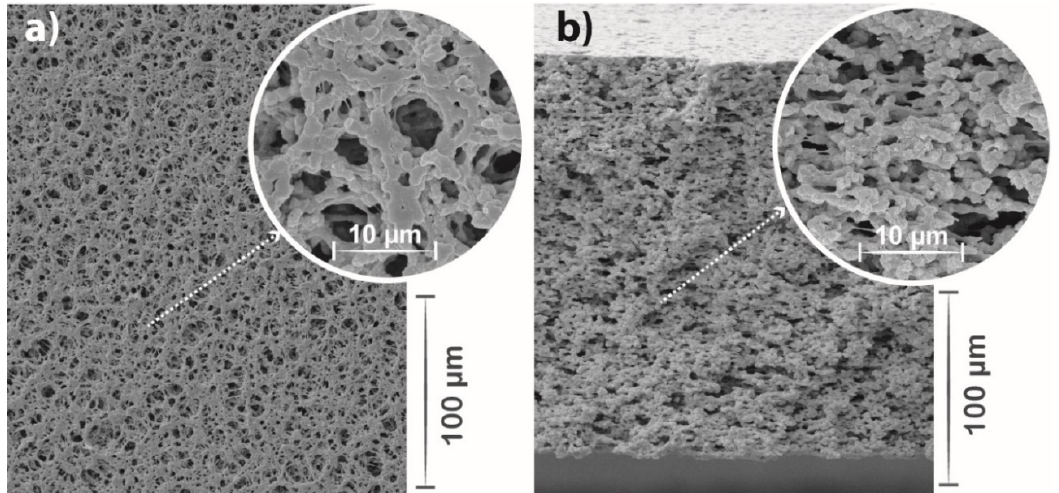
Figure 4. Representative surface ( a ) and cross-section ( b ) SEM micrographs of the 10% Ag@TiO 2 /PVDF-HFP nanocomposite membranes, with the corresponding amplified insets.